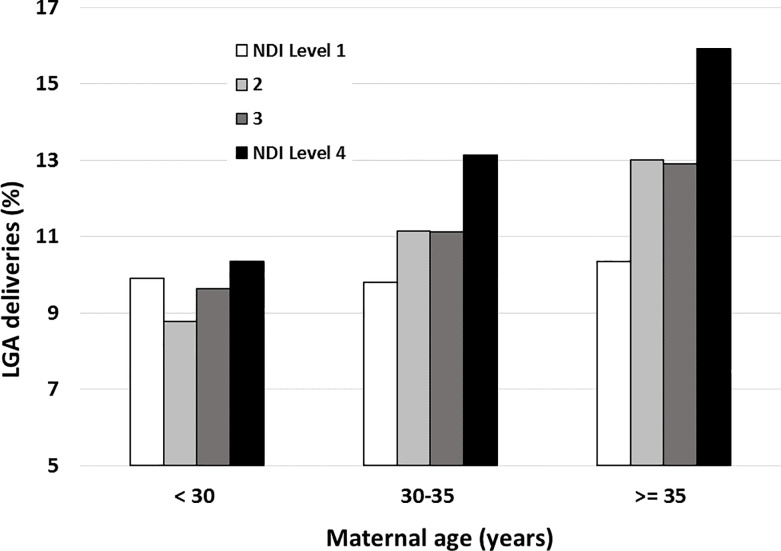
LGA, neighbourhood deprivation index (NDI) and maternal age.The rate of infants born LGA increased gradually with advancing maternal age, and the NDI reached the highest level among infants born to mothers aged 35 years and living in the most deprived neighbourhoods.